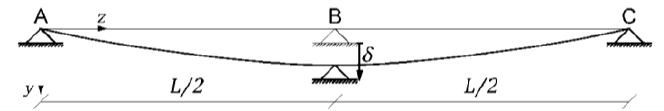
Figure 5. First test–structural scheme. Table 1. First test: Geometrical parameters.